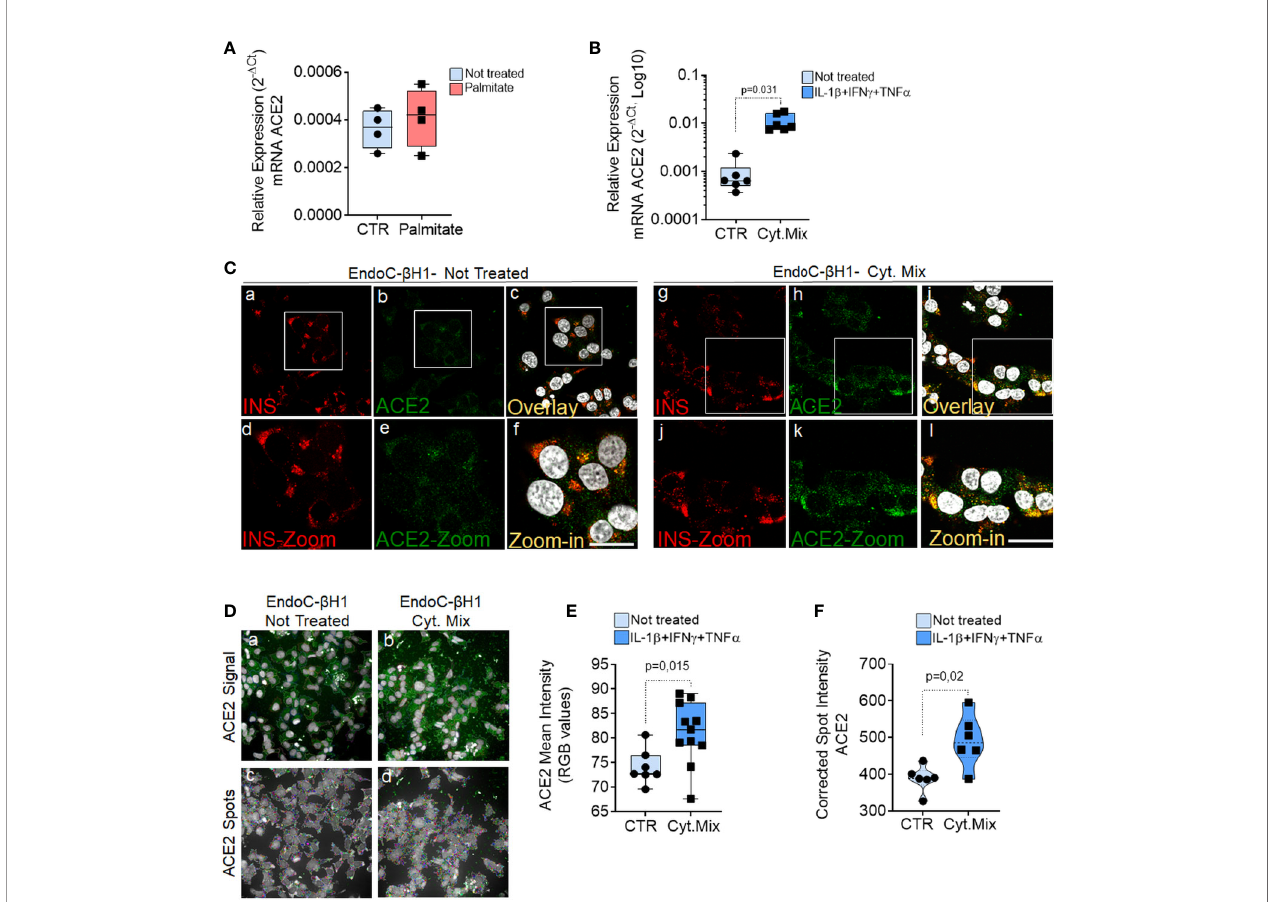
FIGURE 7 | ACE2 expression isincreased byin fl ammatorystress. ACE2 mRNA RT-Real-Time PCR analysis inEndoC- b H1 treated or not (CTR)with Palmitate (2.0 mM) (A) or with cytokines (IL-1 b + IFN g + TNF a ) (Cyt. Mix) (B) for 24 h. Results are reported as mean ± S.Dof2 − dCT normalizedvalues. p-values were calculatedusing Wilcoxon matched-pairssignedrank test. (C) Immuno fl uorescence analysisofinsulin (red,panels-a and -g)and ACE2 (green,panels-band -h)in EndoC- b H1 not-treated (panels-a to -f)ortreated (panels-g to -l) with cytokines for 24 h. Digitalzoom-in images arereported inpanels-d to -fand in panels-jto -l.Scalebar inpanel-f: 10 µm. Scalebar inpanel-l: 15 µm. (D) Representative images of ACE2 staining (green)and analysis using micro-confocal High-content screening in EndoC- b H1 treatedornot with cytokines (IL-1 b + IFN g +TNF a ).Panels-a and-b: ACE2 signal (green)and automated cell cytoplasmsegmentation and identi fi cation.Panels-c and -d:identi fi cation of ACE2 granular spots within segmented cytoplasm inpanels-aand -b. Each ACE2 granular spot intensity was measured and analyzed. (E) Mean intensity imaging analysisrelated to data reported in (C) of EndoC- b H1 treatedornot with cytokines. Dataare reported as individual values alongside with mean ± S.DofRGB gray-intensity measures of 6 – 11 different experimental points related to two different independent experiments. Individual values alongsidewith mean ± S.D are reported. P-value was calculatedusing Mann – Whitney U test. (F) High content screeninganalysis of Corrected Median Spot intensity of ACE2 signal inEndoC- b H1 treated or not with cytokines. Median intensity values ofsix different experimental points are reported. P-value was calculatedusing Mann – Whitney U test (p <